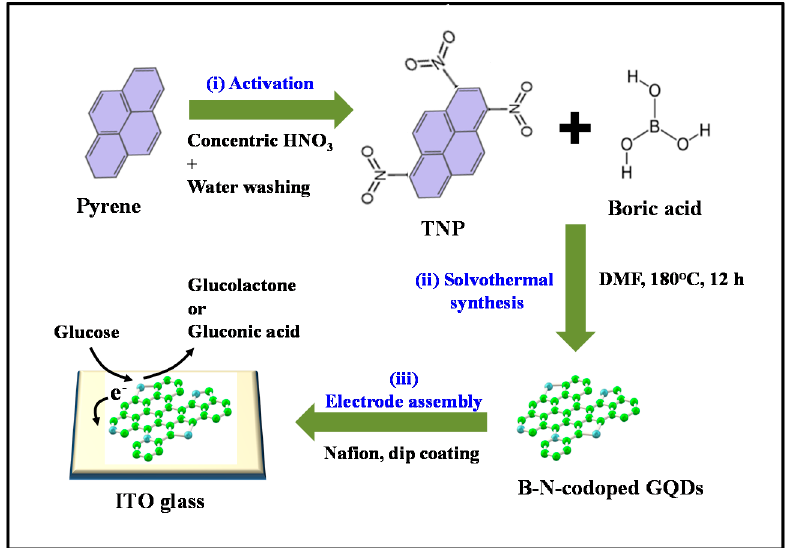
Figure 5. Schematic diagram of synthesizing B-N-codoped GQDs through the solvothermal synthesis method for glucose oxidation.